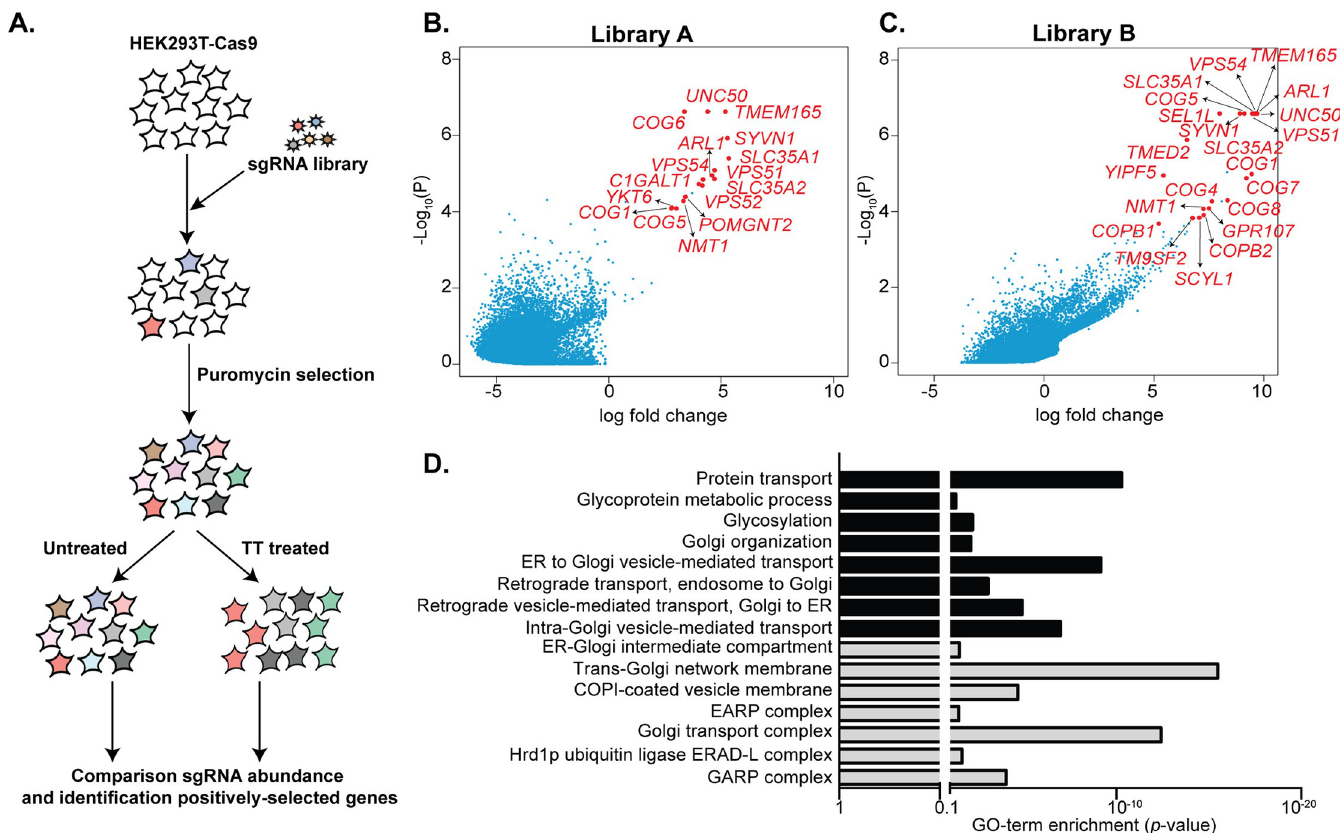
Fig 2. A genome-wide CRISPR/Cas9-mediated gene inactivation screen identifies genes essential for typhoid toxin intoxication. (A) A schematic of the workflow for the screen to identify genes involved in typhoid toxin toxicity. HEK293T cells expressing Cas9 were transduced with a lentiviral library encoding sgRNA targeting human genes as described in Material and Methods. After puromycin selection, cells were split and either mock treated or treated with typhoid toxin. Cells that survived the toxin treatment or that were mock treated were subjected to nucleotide sequence analysis as indicated in Materials and Methods. Sequences were aligned to the reference genome and high-quality reads were analyzed with the MAGeCK algorithm to identify positively-selected genes. (B and C) Scatter plots of effect size (log fold change; x axis) versus P value (-log 10 raw P -value; y-axis) for all genes. Three replicates were performed for each sub-library and the MAGeCK algorithm was used to compare treated with untreated cells across replicates for the human GeCKO v.2 sub-library A and B as described in Material and Methods. Inactivation of the genes colored in red conferred resistance to typhoid toxin with a P -value cutoff corresponding to 15% FDR. (D) Gene ontology term enrichment analysis of genes whose inactivation conferred toxin resistance. The P -values represent the probability of the identified genes to be annotated to a particular GO term relative to all the annotated human genes. GO terms are shown depicting biological processes in black and cellular components in